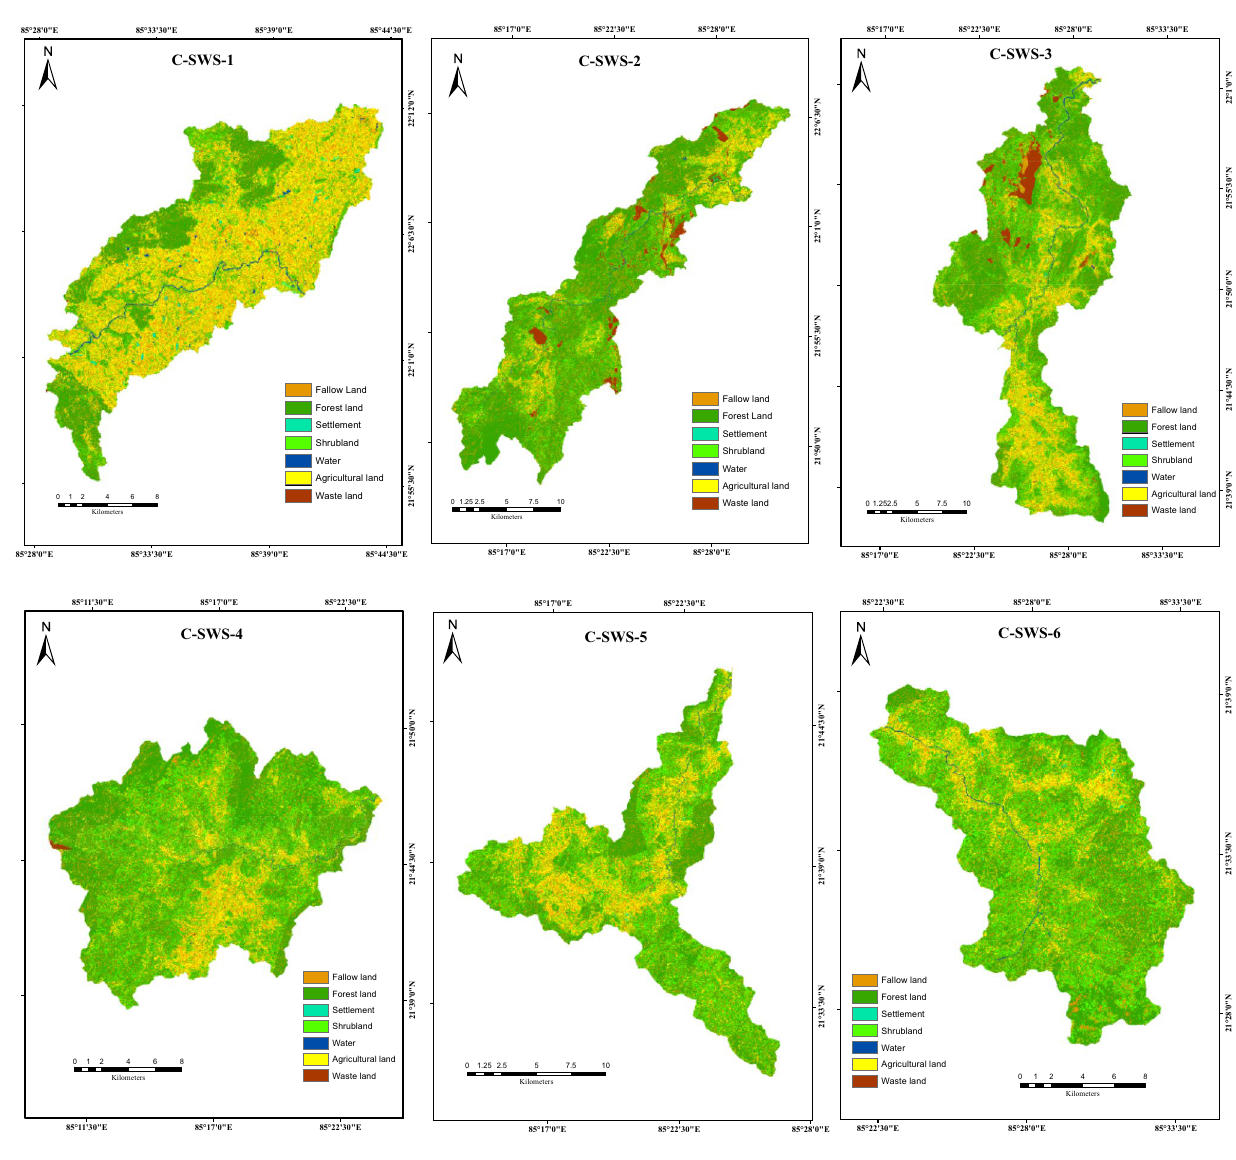
Fig. 6 LULC maps of six sub-watersheds of Champua watershed for the year